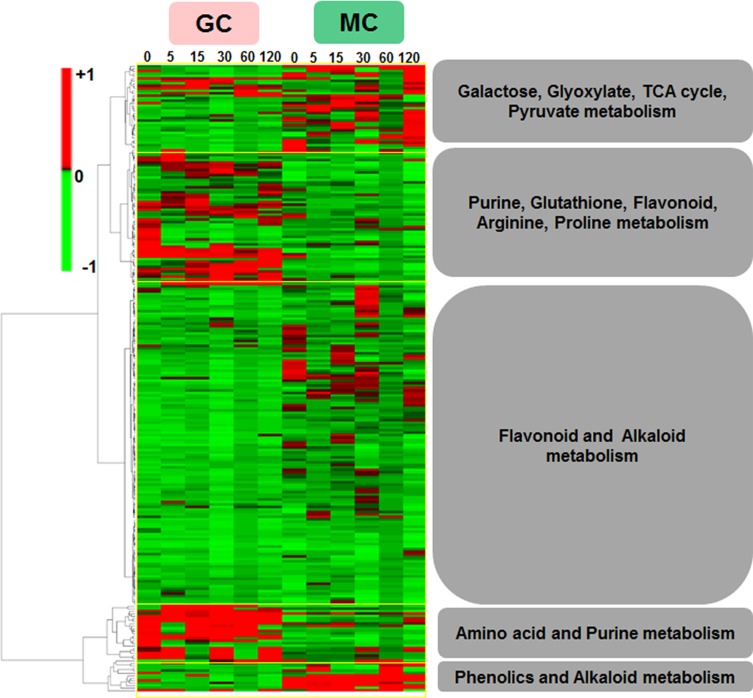
Hierarchical cluster analysis (HCA) of mean values of metabolite contents from four biological replicates showing 268 metabolites common to the two cell-types depicting the data structure dependent on the cell-types and time course (0–120 mpi) of HCO3
- treatment.Red and green indicate high and low concentrations of metabolites, respectively. Values were subjected to average linkage clustering (Euclidean distance). Outlined blocks in yellow show grouped metabolites in the two cell-types.